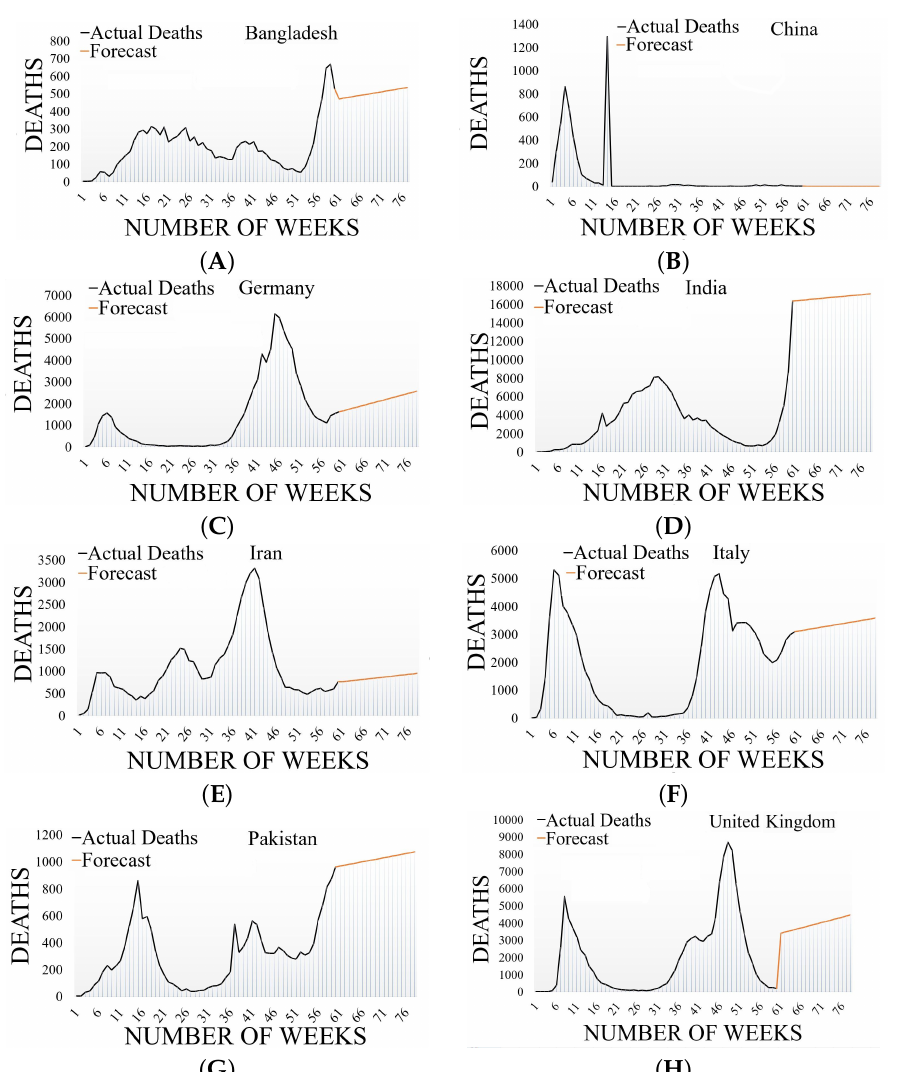
Figure 5. Actual deaths in 60 weeks and predicted deaths in future